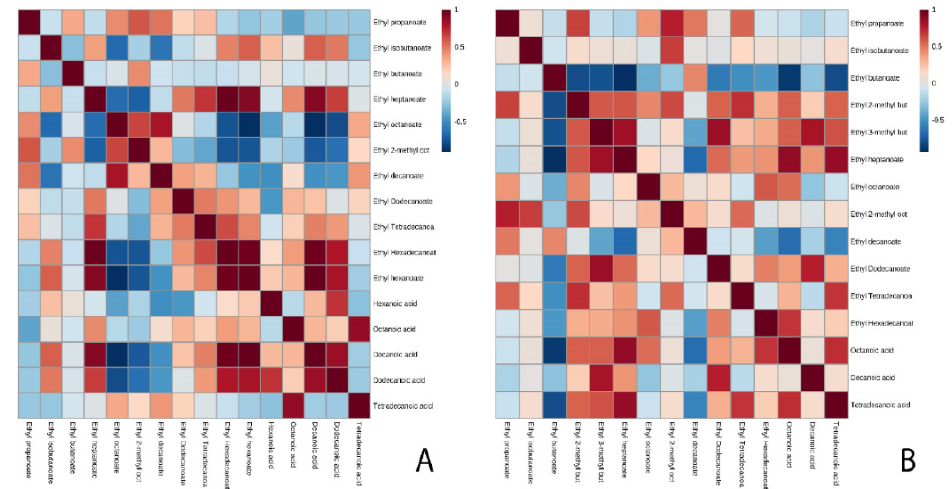
Figure 6. Matrix of correlations established between esters and fatty acids in the CO 2 overpressure condition for the flor yeast ( A ) and the P29 strain ( B ).